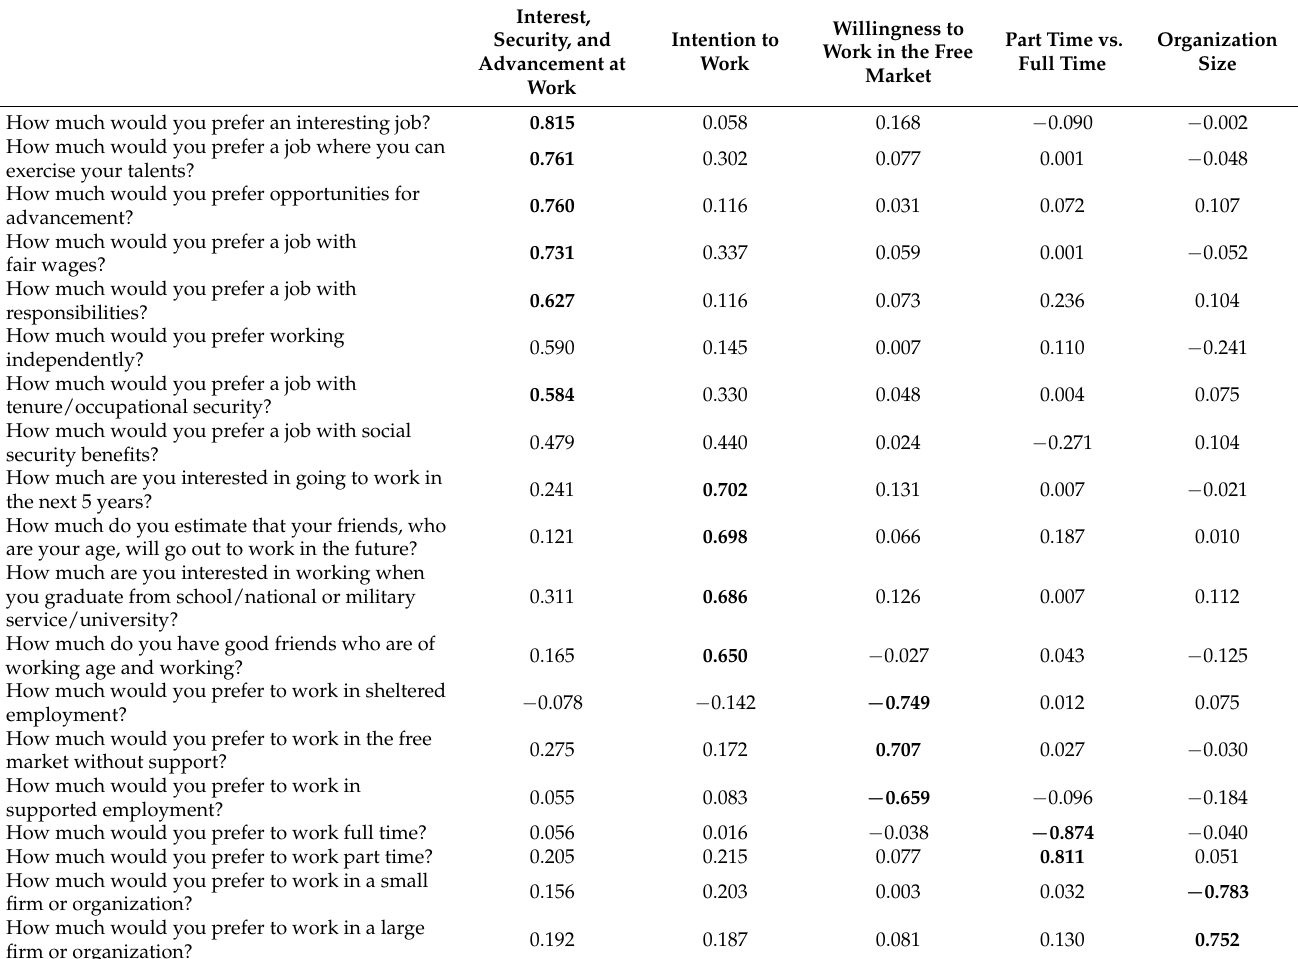
Table 2. Factor loading by EFA (pattern matrix of factors and items).